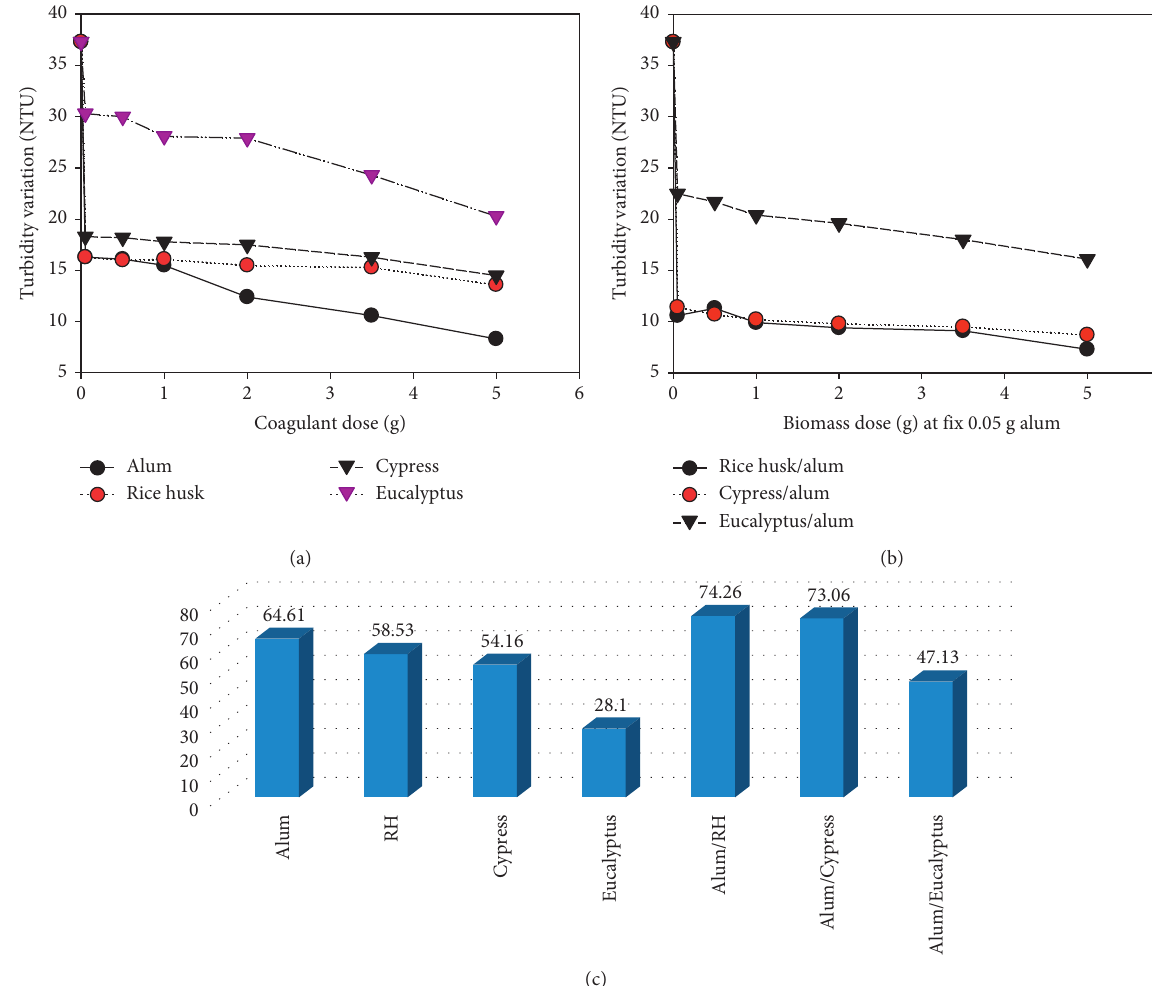
Figure 4: MSW variation of turbidity with (a) individual and (b) mixed coagulants and (c) coagulation activities